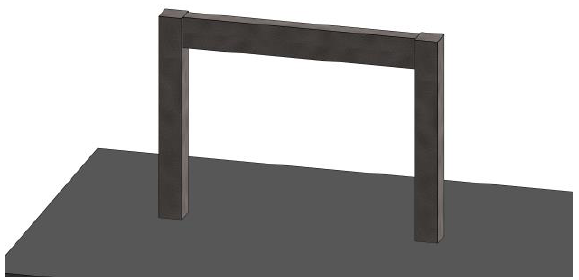
Figure 3. The preposition model of the infilled wall masonry process design model.